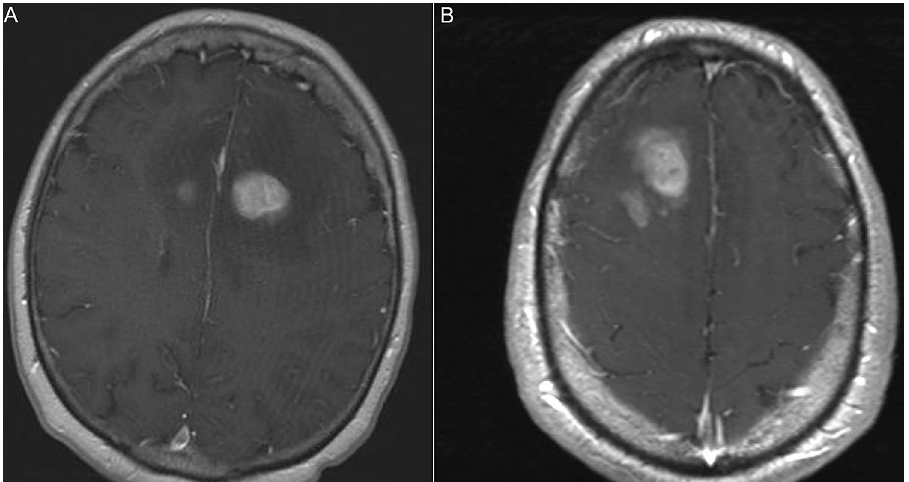
Figure 1. Representative MR images for classification. (A) Contrast-enhanced T 1 -weighted image of a 71-year- old woman with primary central nervous system lymphoma in the right thalamus. (B) Contrast-enhanced T 1 - weighted image of a 70-year-old man with primary central nervous system lymphoma in the right frontal lobe.